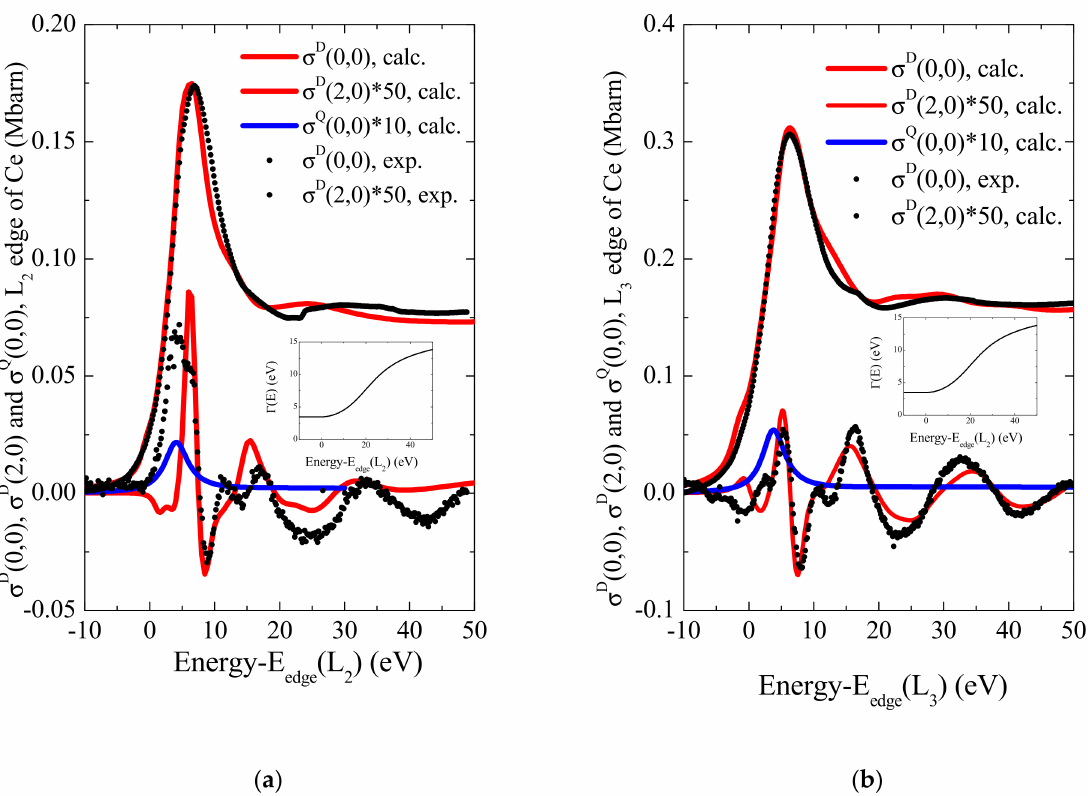
Figure 8. ( a ) Isotropic and anisotropic resonant contributions to the X-ray absorption cross section near L 2 absorption edge of Ce (points are coefficients obtained from experimental data, red lines—calculation), as well as the isotropic quadrupole contribution to the absorption cross section (blue line). The inset shows the dependence of the total width of the excited state on energy used in the calculations. ( b ) Isotropic and anisotropic resonant contributions to the X-ray absorption cross section near L 3 absorption edge of Ce (points are coefficients obtained from experimental data, red lines—calculation), as well as the isotropic quadrupole contribution to the absorption cross section (blue line). The inset shows the dependence of the full width of the electron–hole state Γ ( E ) on energy used in the calculations. E edge (L 2 ) = 6164 eV, E edge (L 3 ) = 5723